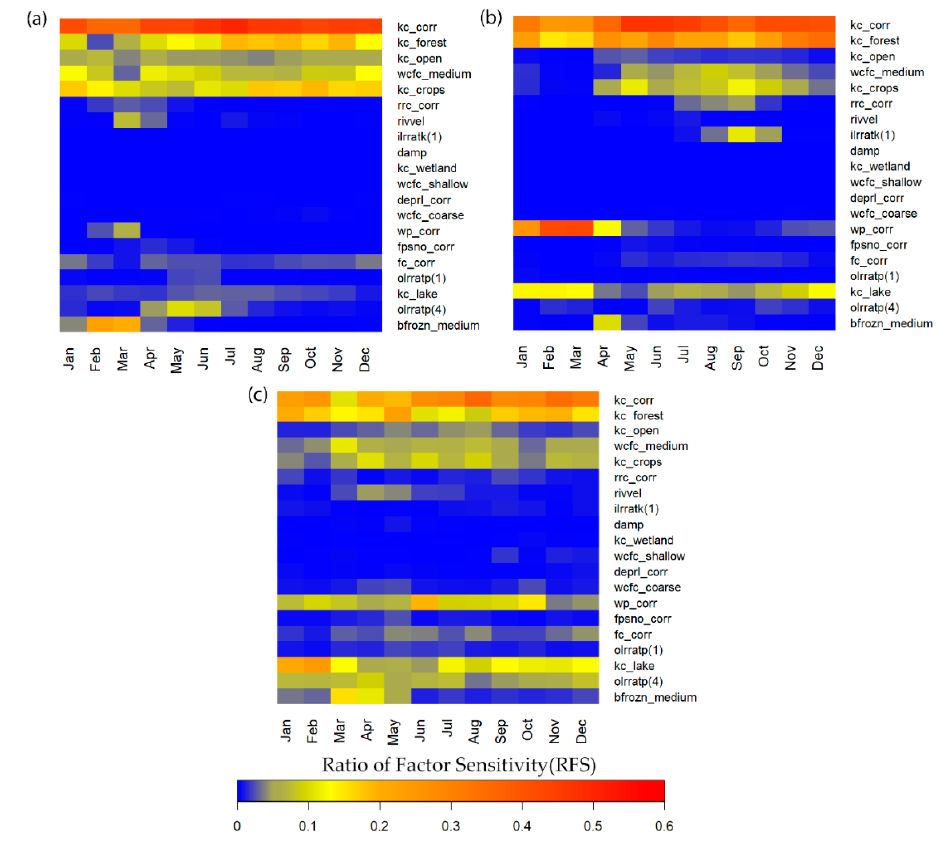
Figure 7. Heat map representing the sensitivity of model parameters expressed as a ratio of factor sensitivity based on ( a ) 3-day averaged Q 5 , ( b ) 3-day averaged Q 95 , and ( c ) slope of Flow Duration Curve for the evaluation period of